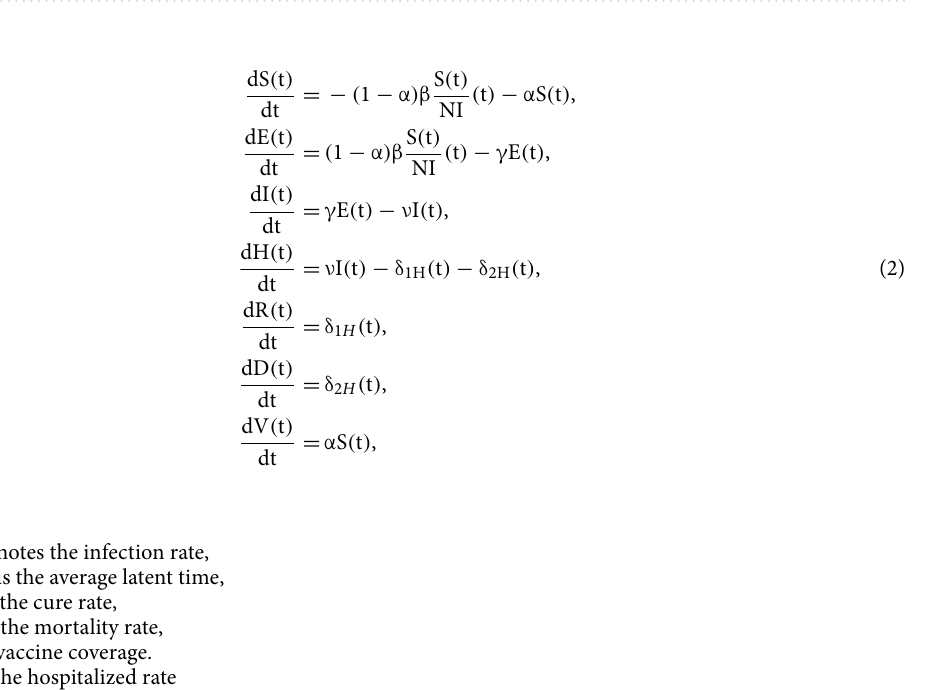
Figure 1. SEIHRDV model. The diagram for SEIHRDV model that S, E, I, H, R, D and V are the number of susceptible individuals, exposed individuals (persons in the incubation period after being infected by the disease pathogen), infected individuals, hospitalized individuals, recovered individuals, death individuals and vaccinated individuals,